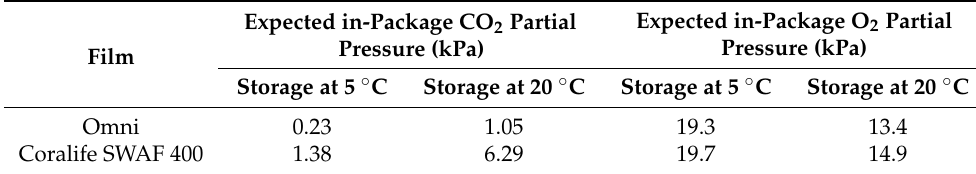
Table 2. Expected in-package CO 2 and O 2 partial pressure. Calculations were carried out assuming a respiration rate of 3.5 (5 ◦ C) and 16 mL CO 2 kg − 1 h − 1 (20 ◦ C), and a film package surface equal to 0.36 m 2 . The ratio of CO 2 released to O 2 consumed was considered equal to